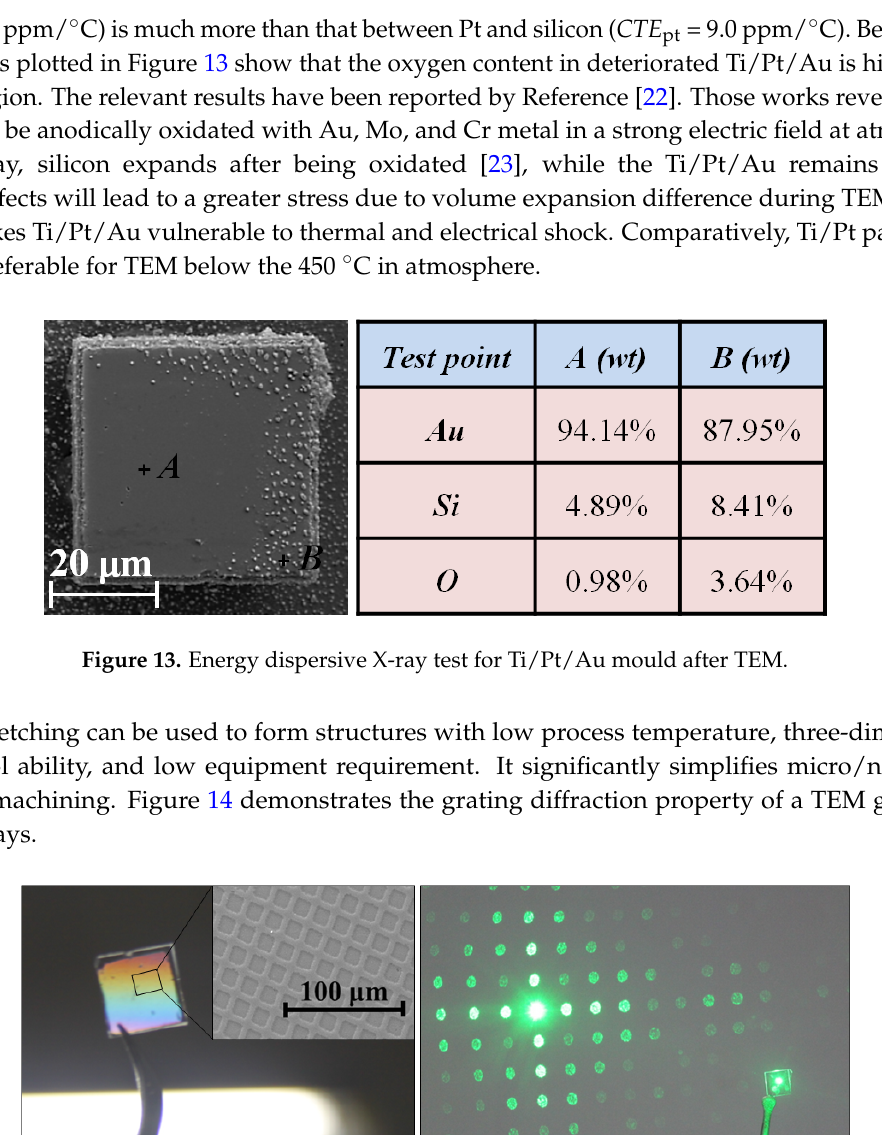
Figure 14. ( a ) TEM etched glass; ( b ) Interference phenomenon by the TEM etched glass.